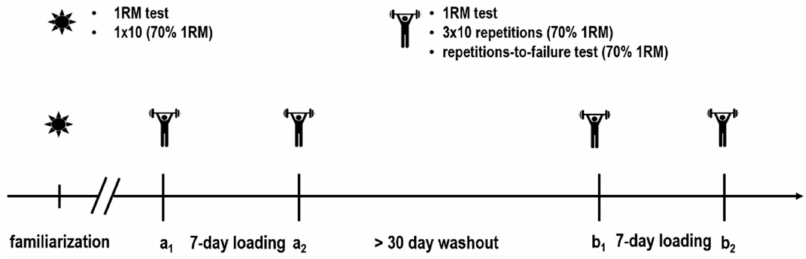
Figure 1. Study design. 1RM = one repetition